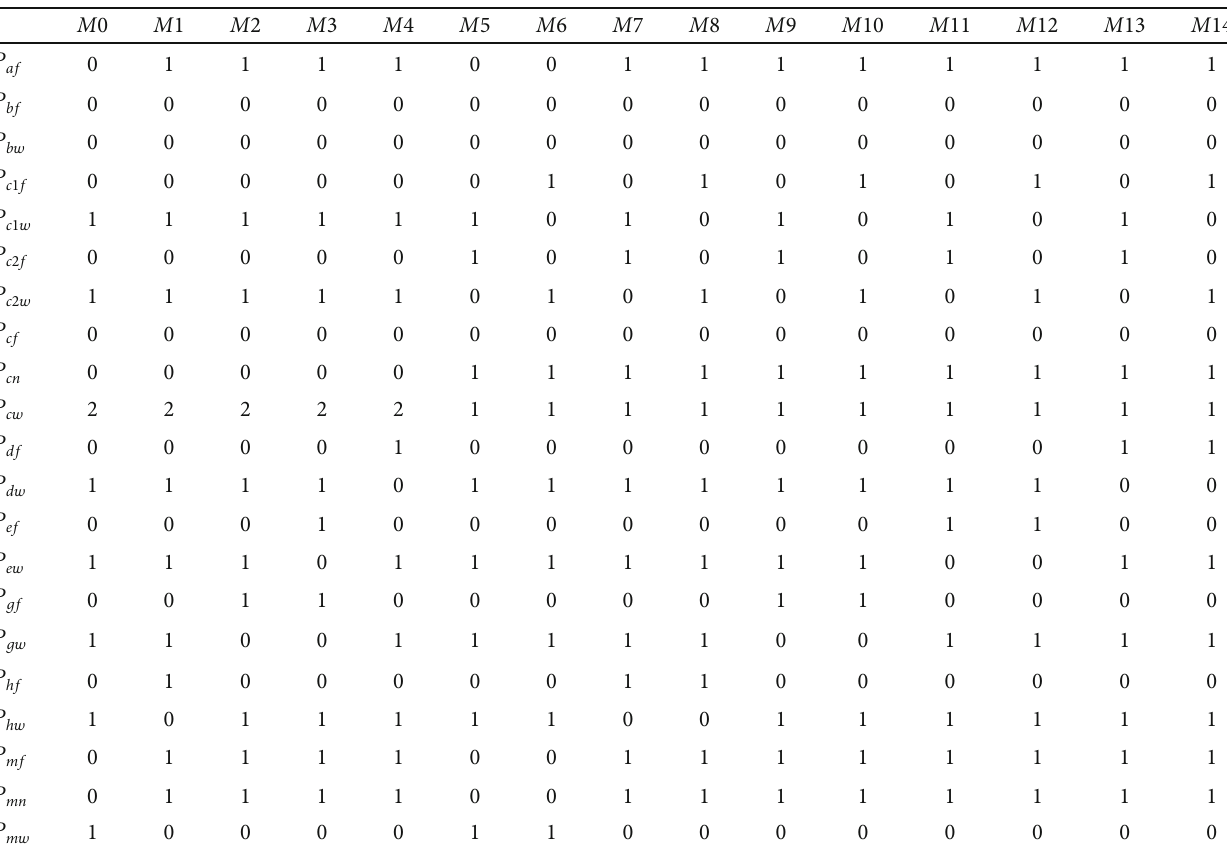
Table 7: GSPN steady-state analysis results set of Tangible states.